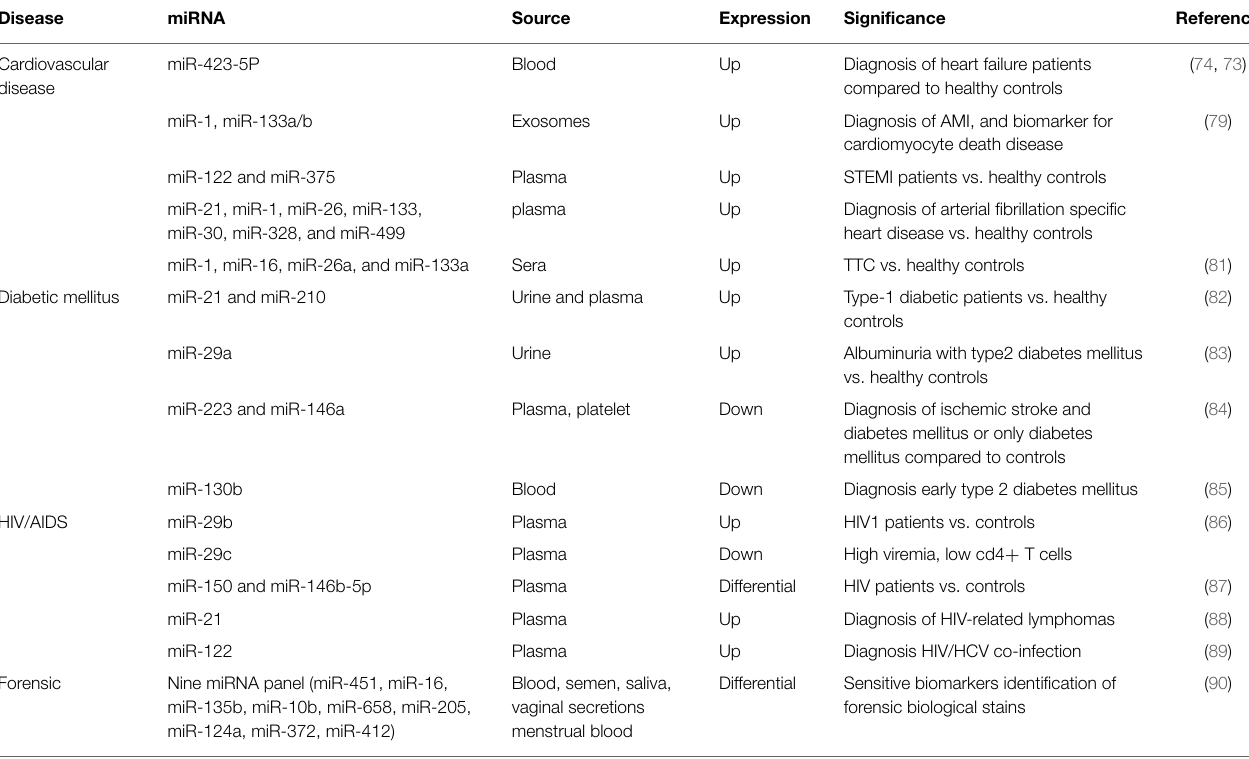
TABLE 3 | Circulating miRNAs a potential diagnostic biomarkers in other disease .